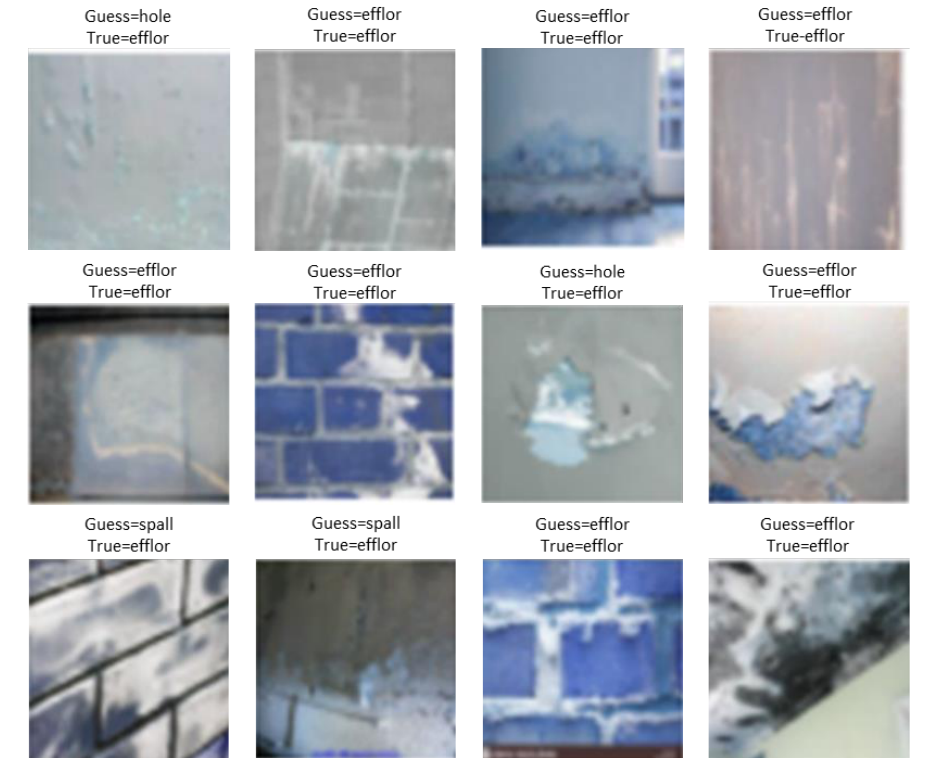
Figure 10. Prediction of wall defects by Conv2D DenseNet base model.